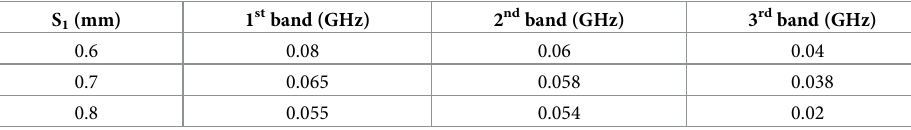
Table 5. Simulated result of coupling coefficient for different values of S 1 .